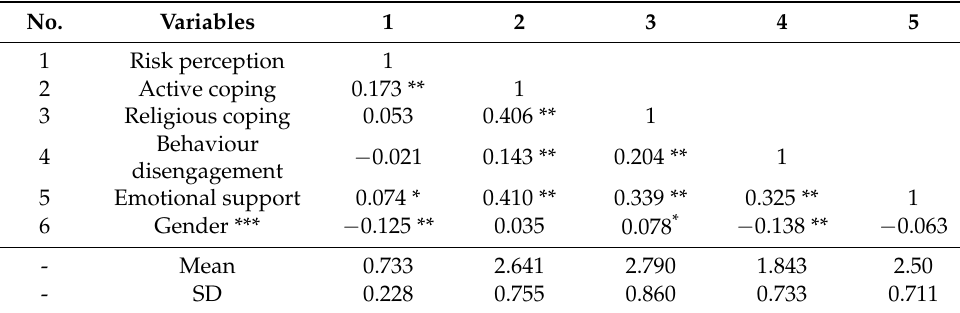
Table 1. Descriptive statistics for the study variables.